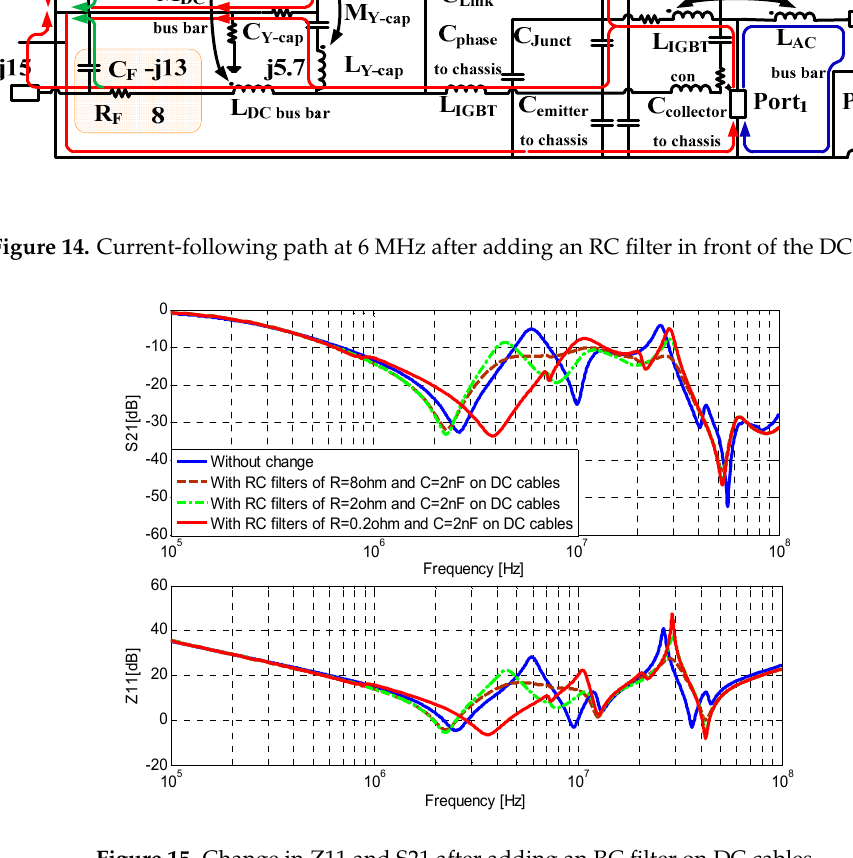
Figure 15. Change in Z11 and S21 after adding an RC filter on DC cables.